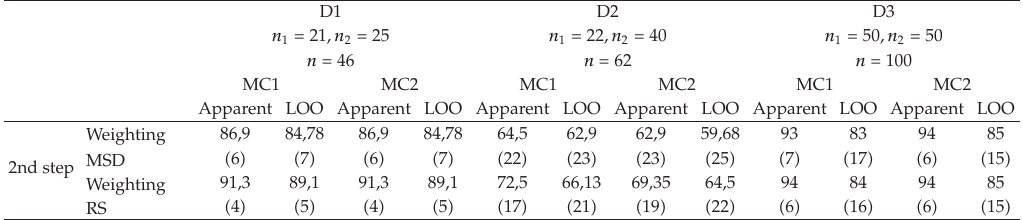
Table 5: The apparent and LOO hit rates (cid:2) in percentage (cid:3) of MC1 and MC2 models. D1 D2 D3 n 1 (cid:8) 21 ,n 2 (cid:8)